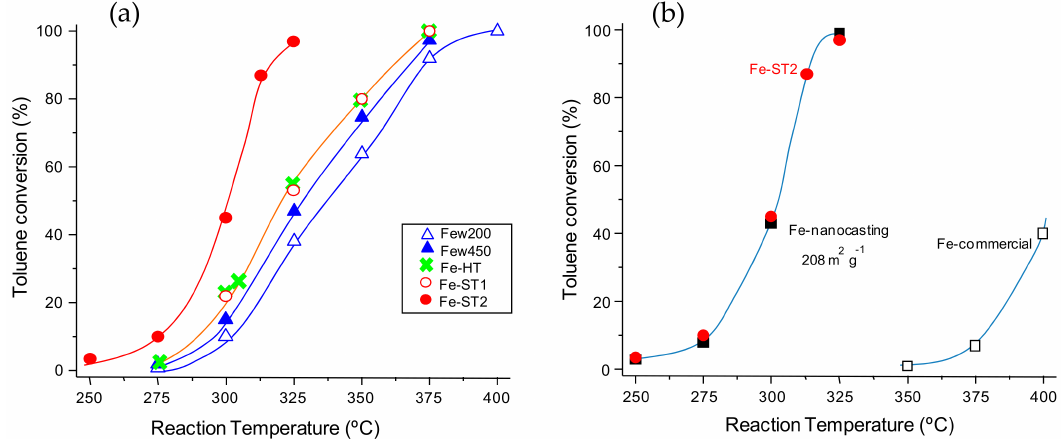
Figure 1. Evolution of the toluene conversion with the reaction temperature for the differently prepared FeOx catalysts: ( a ) comparison of the iron oxides synthesized in the present work, ( b ) comparison between Fe-ST2 catalyst and representative catalysts Fe-com and Fe-nano. Note: Gas Hourly Space Velocity (GHSV) = 300,000 h − 1 and remaining reaction conditions detailed in the text. Symbols: ∆